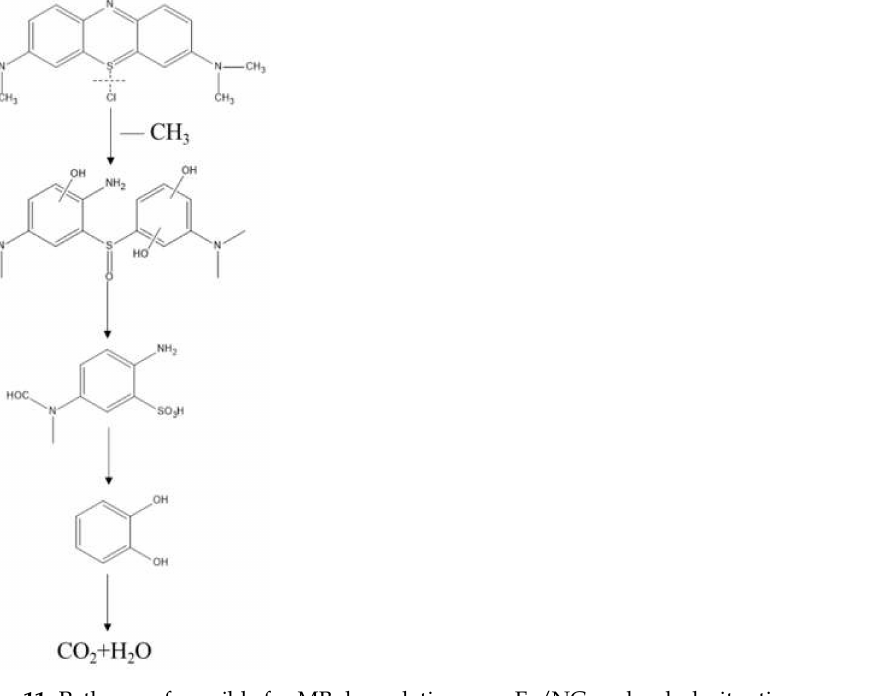
Figure 11. Pathway of possible for MB degradation over Fe/NG under dark